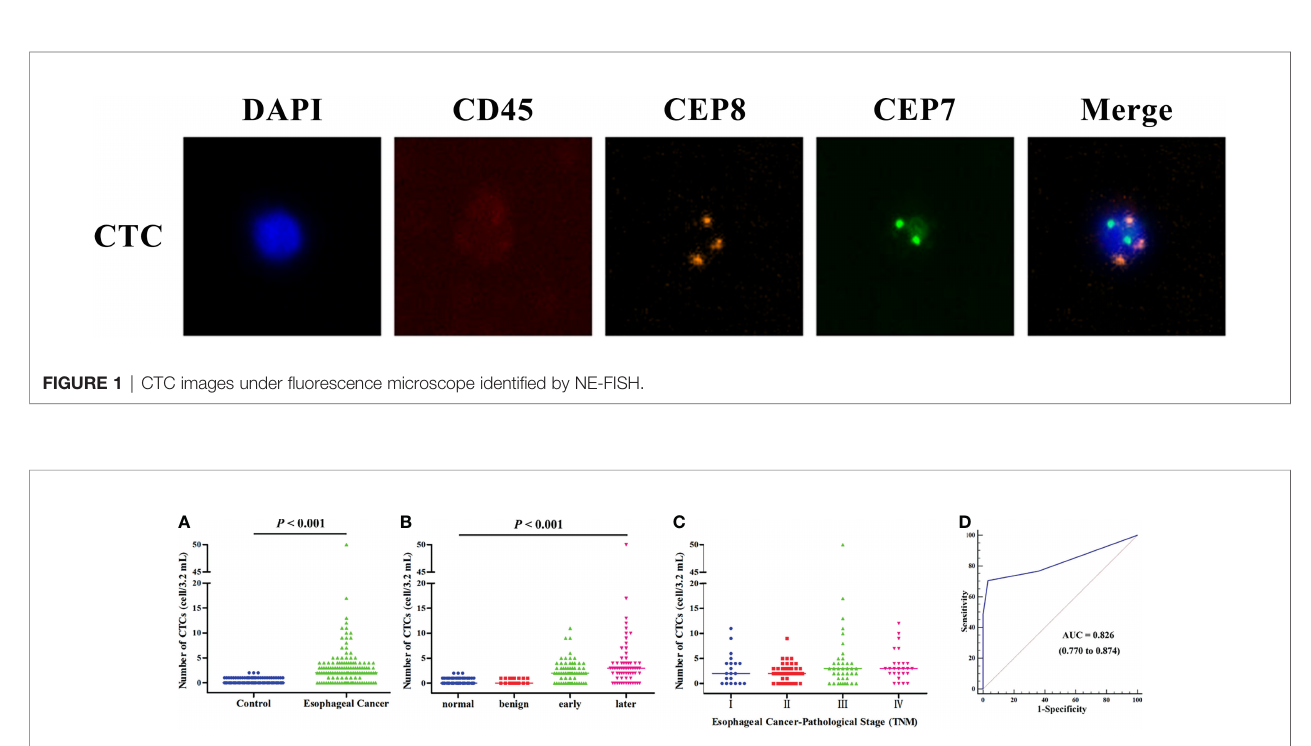
FIGURE 2 | (A) The distribution of CTCs in the control and EC groups. (B) The distribution of CTCs in healthy, benign, early-stage (I – II), and late-stage (III – IV) patients. (C) The distribution of CTCs in different stages of EC patients. (D) ROC curve was applied to determine the cutoff value of CTCs in the present